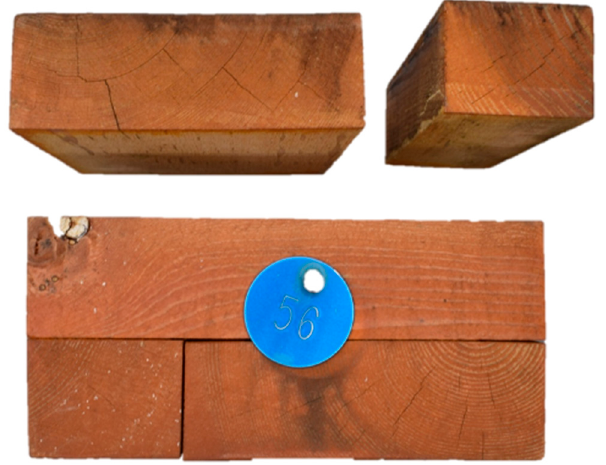
Figure 7. Delamination of coated CLT (I Alk) after 12 months of outdoor exposure.